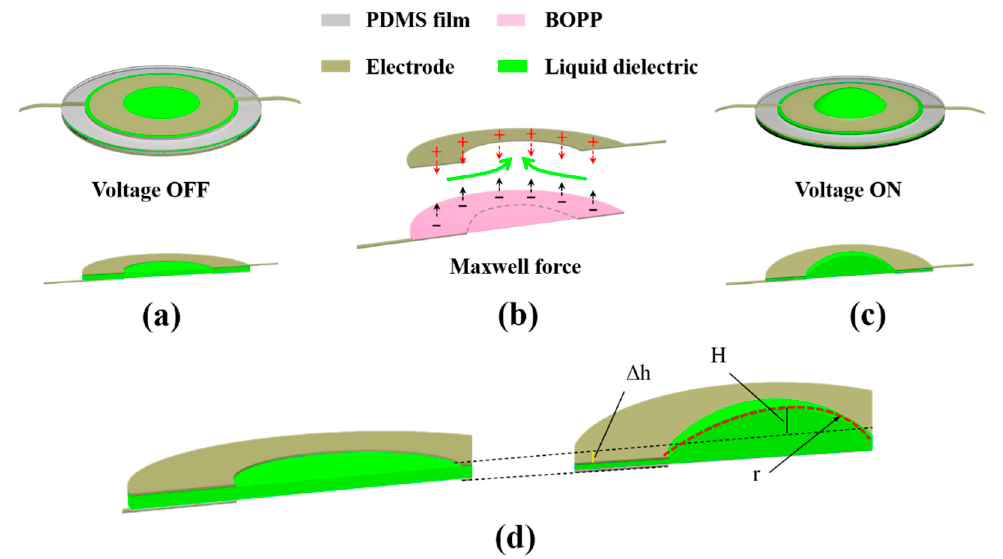
Figure 2. Schematic diagram of the electro-hydraulic haptic feedback actuator with ( a ) Voltage OFF and ( c ) Voltage ON. ( b ) The action principle of the actuator. ( d ) Cross section of the actuator before and after power on.